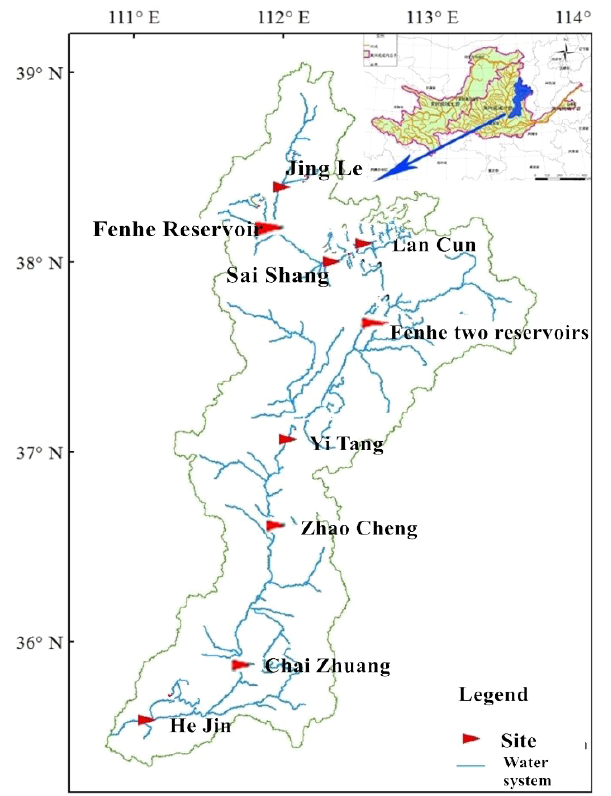
Figure 1. Fenhe River